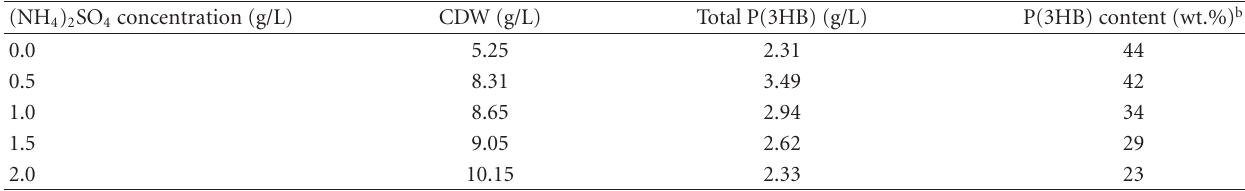
Table 3: E ff ect of (NH 4 ) 2 SO 4 concentration on biosynthesis of P(3HB) a